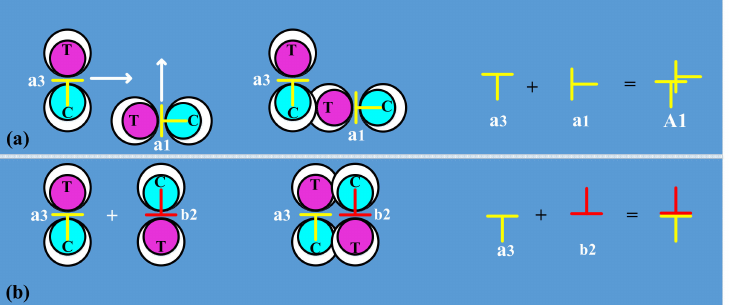
Figure 5. ( a , b ) respectively represent the stress distribution diagram of new dislocation pairs formed by edge dislocations a1 and a3 perpendicular to each other in Figure 3b, and the annihilation of edge dislocations a3 (A1 formed by a1 and a3) and b2 with opposite Burger vectors from Figure 3b,c. C and T are the compressed and stretched regions, respectively. The white arrow indicates the slip direction of the edge dislocation. The above (below) extra half plane of atoms is subjected to compressive (tensile)